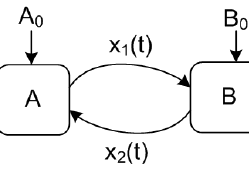
Figure 8. Illustration of the waveform relaxation